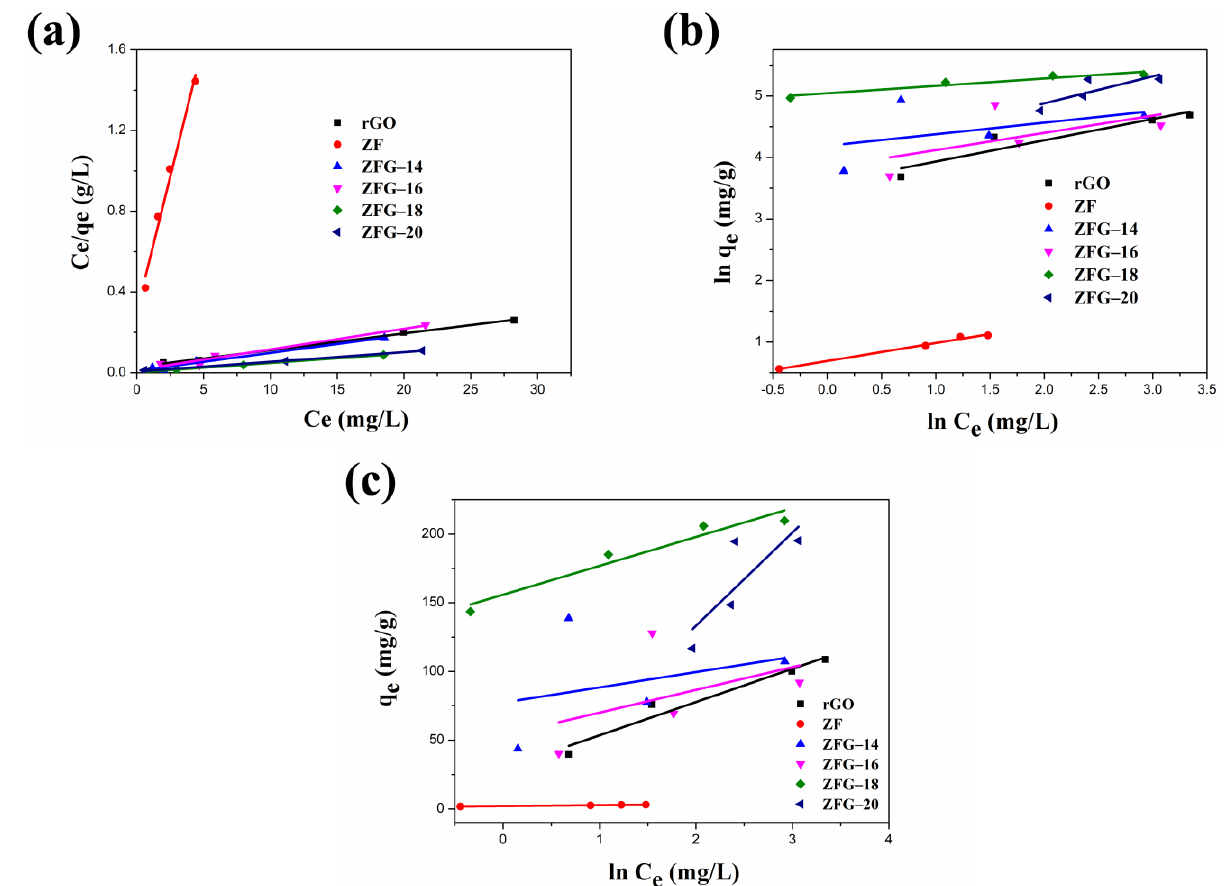
Figure 8. Linear fitting of ( a ) Langmuir, ( b ) Freundlich, and ( c ) Temkin adsorption isotherm. Conditions: adsorbent dosage = 10 mg, time = 30 min, MB concentration = 10 mg L −1 , T = 295 K. Table 5. Fitting parameters of Langmuir, Freundlich, and Temkin adsorption isotherm of as-prepared samples. Table 6. Maximum adsorption capacity of MB on various Models